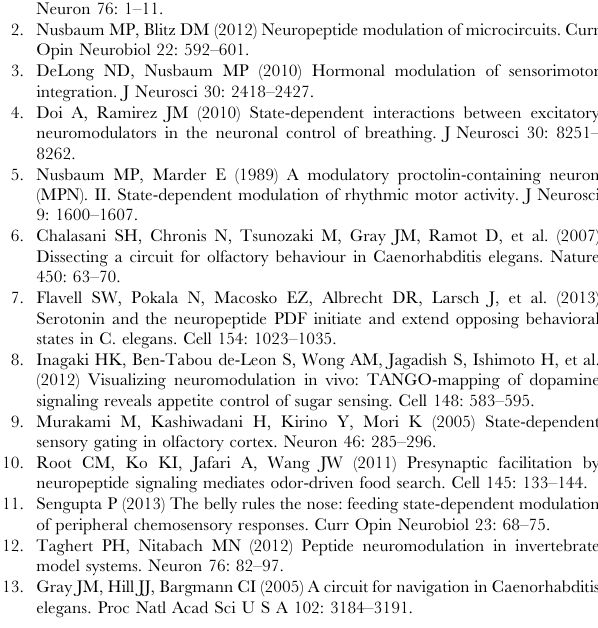
Figure S4 Requirement of DVA and nlp-12 for L-AChR( gf ) locomotor effects. ( A, B ) Average body length (A) and track length (B) for the genotypes indicated. DVA ablation or deletion of the neuropeptide gene nlp-12 normalizes the movement of L-